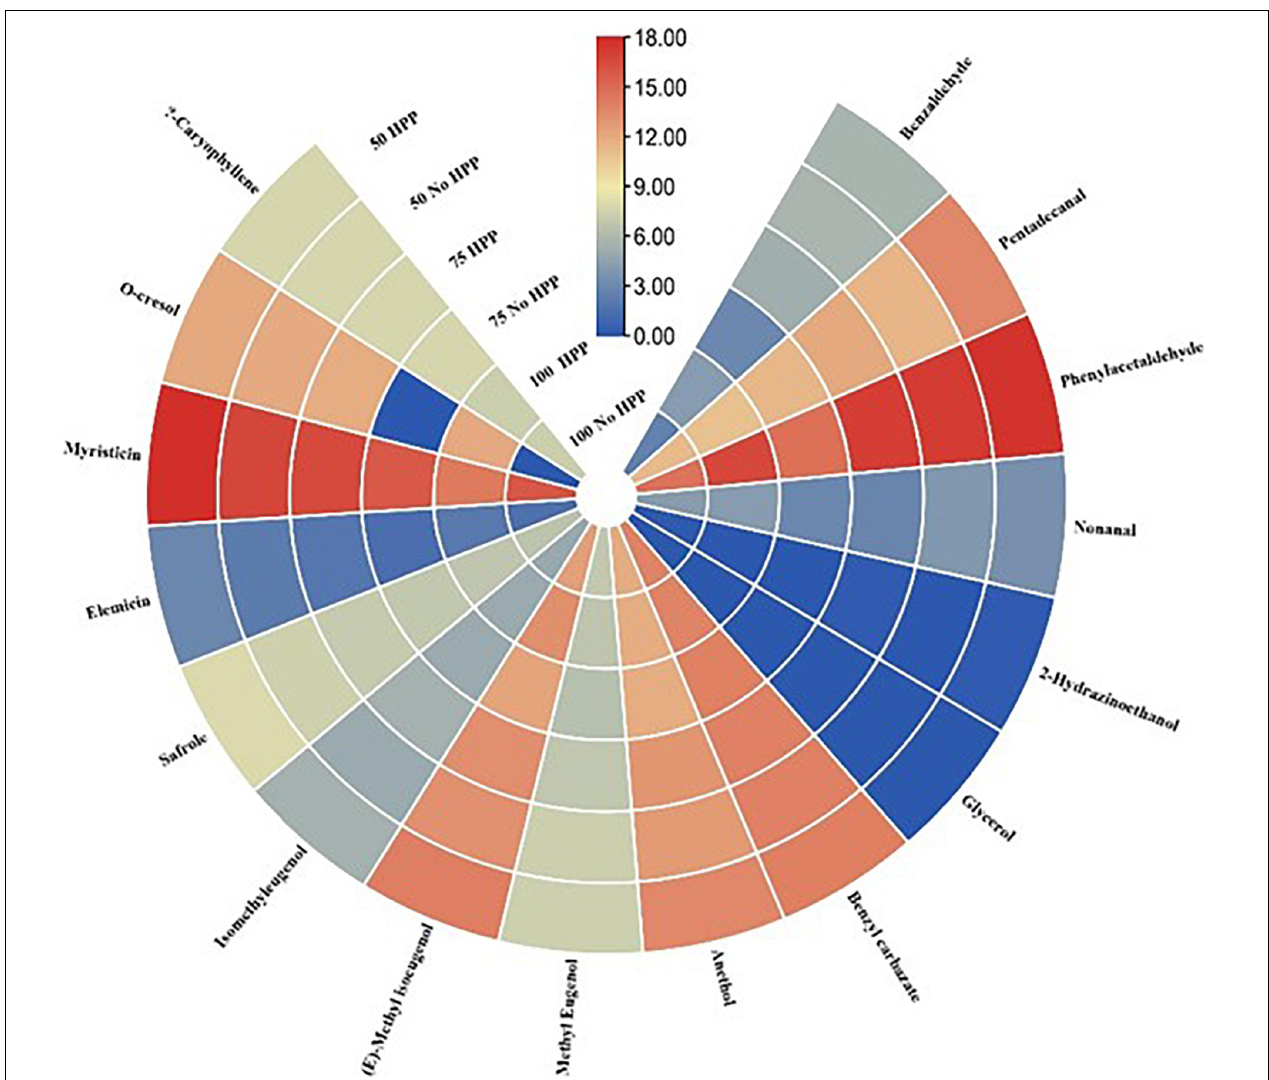
FIGURE 8 | Heat map of odor activity values (OAVs) of volatile compounds in sausage stored at 21 days. The color scale indicates the intensity of the OAV.